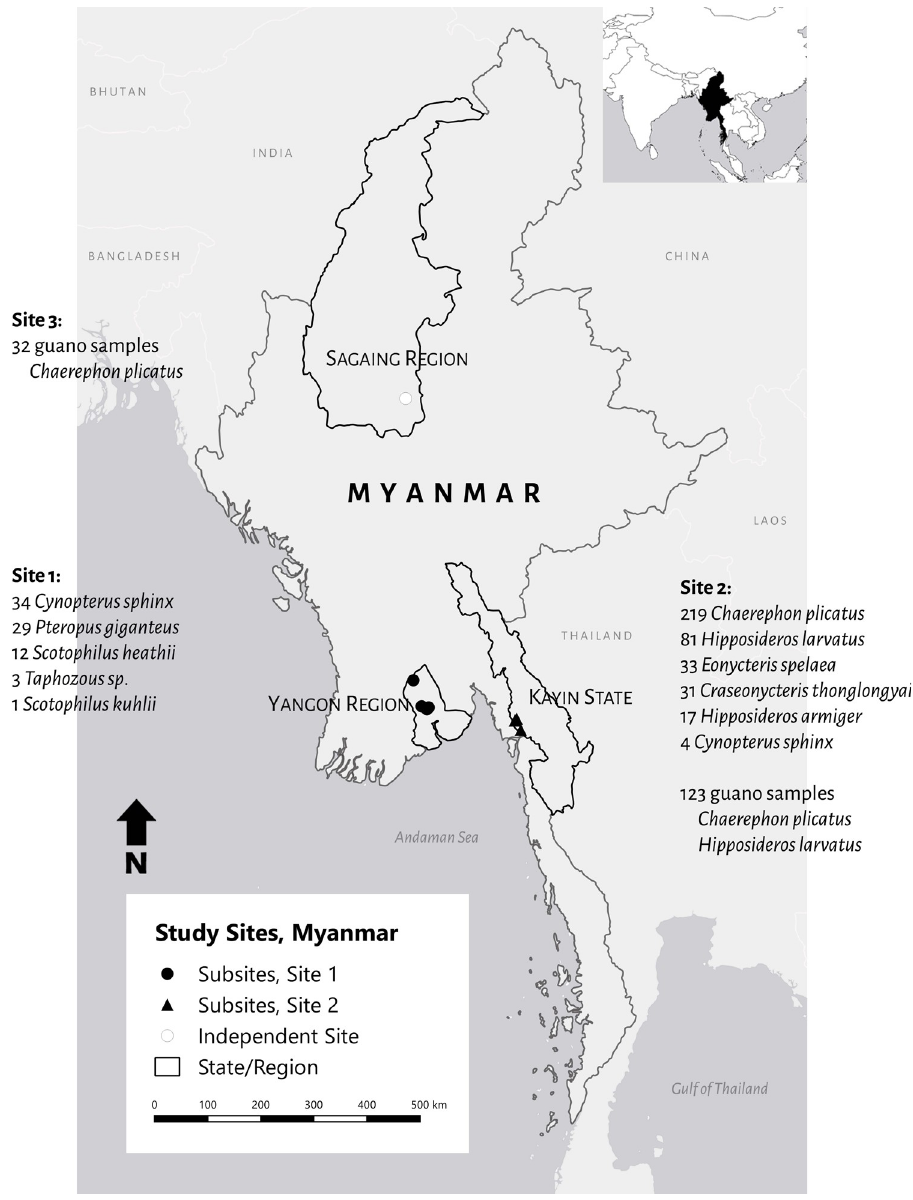
Fig 1. Myanmar study sites. Map of bat capture sites in Myanmar, 2016–2018. Data Sources: Natural Earth. Map created in QGIS 2.18.4.